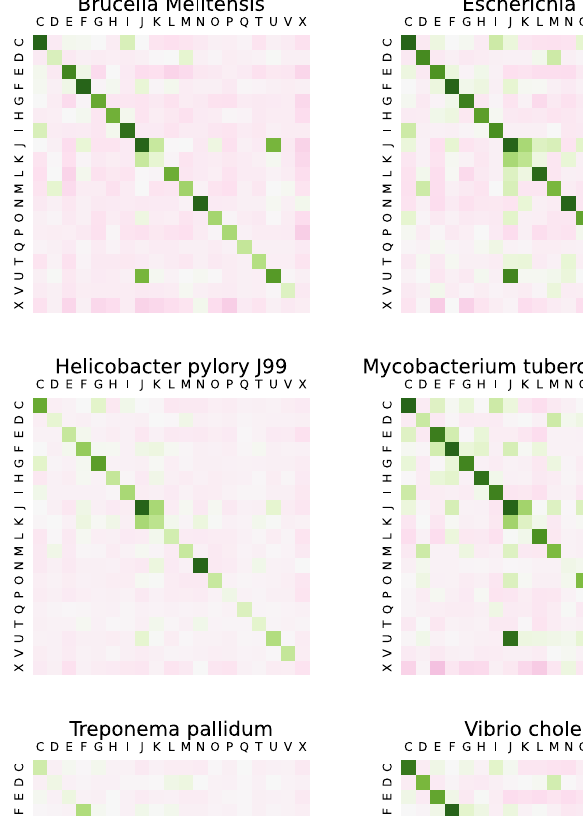
Figure 1. Heat-maps corresponding to Z matrices of the ten organism PPI networks. Diagonal entries correspond to intra-community edges z -scores, while off-diagonal entries correspond to inter-community edges z -scores. Values in the color scale have been cut to interval